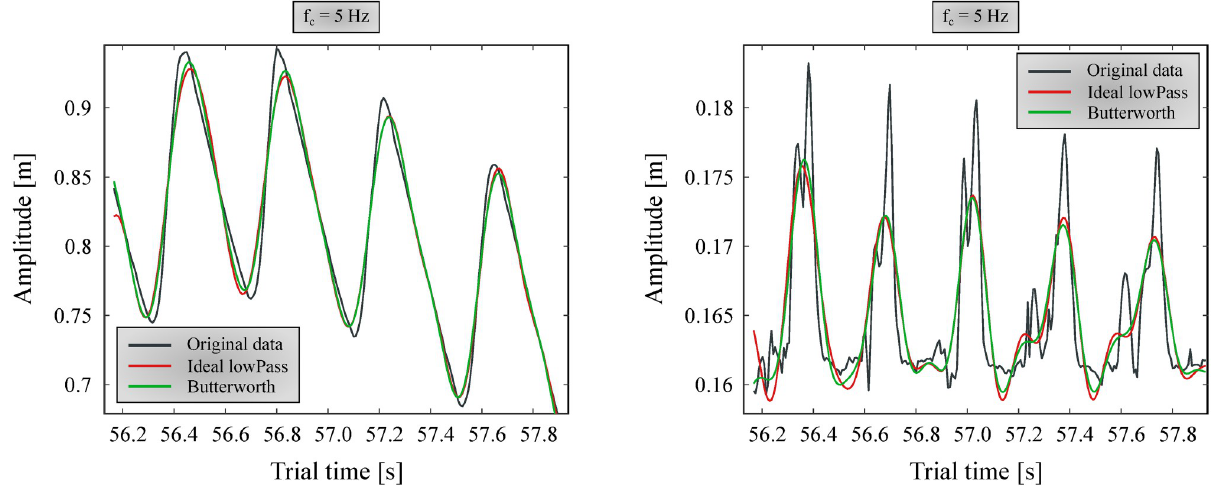
Fig 4. Position data of FR5 marker of the smallest dog filtered with f c = 5 Hz. Ideal low-pass and 6th order Butterworth filters are shown in figure. Left: forward direction; Right: vertical direction.